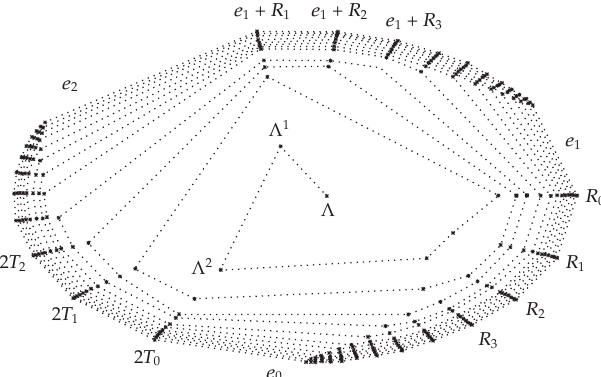
of the lacunary function Λ . n ∈ N 0